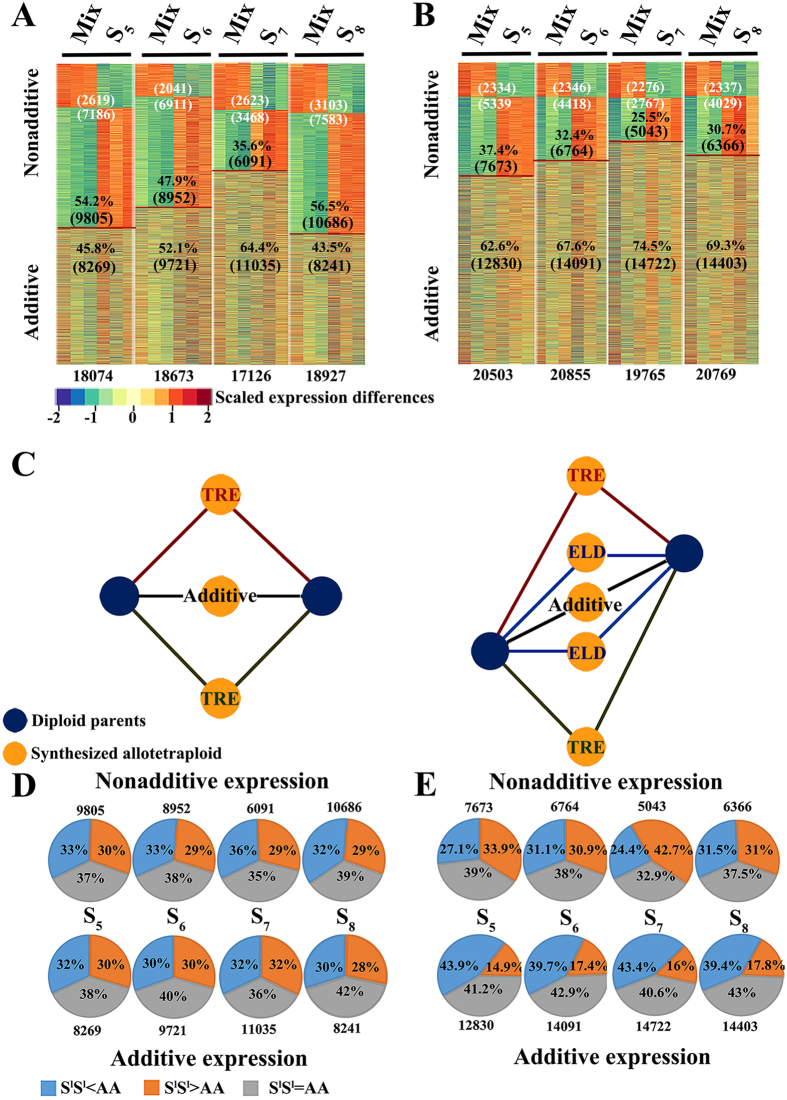
Summary of microarray-based nonadditive and additive gene expression in AT2 including the four major expression patterns and their relationships with parental expression conditions.Nonadditive and additive expressing genes in leaf (A) and young-inflorescence (B) of AT2 at generations S5 to S8 are shown. Numbers and proportions of the nonadditive (above the red lines) and additive (below the red lines) expressing genes are indicated. Numbers of the total expressing genes are shown at the bottom. Different expression space by the parental expression-conserved genes (PEC) and the parental expression-different genes (PED) in AT2 are diagrammed (C). PEC genes can exhibit additive expression and transgressive expression (TRE), while, apart from additive expression and TRE, PED genes may also show higher or lower parental expression level dominance (ELD). The proportions of the non-additive and additive genes that are PEC (SlSl = AA) or PED (SlSl ≠ AA) in leaf (D) and young-inflorescence (E) of AT2 from S5 to S8 are shown by pie charts. Each pie represents the total number of the nonadditive or additive genes at a given generation of AT2, which was divided into three colored parts based on its relationships with parental expression conditions.